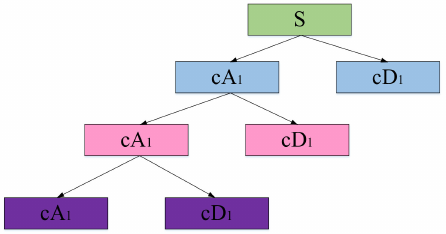
Figure 1. Schematic diagram of wavelet